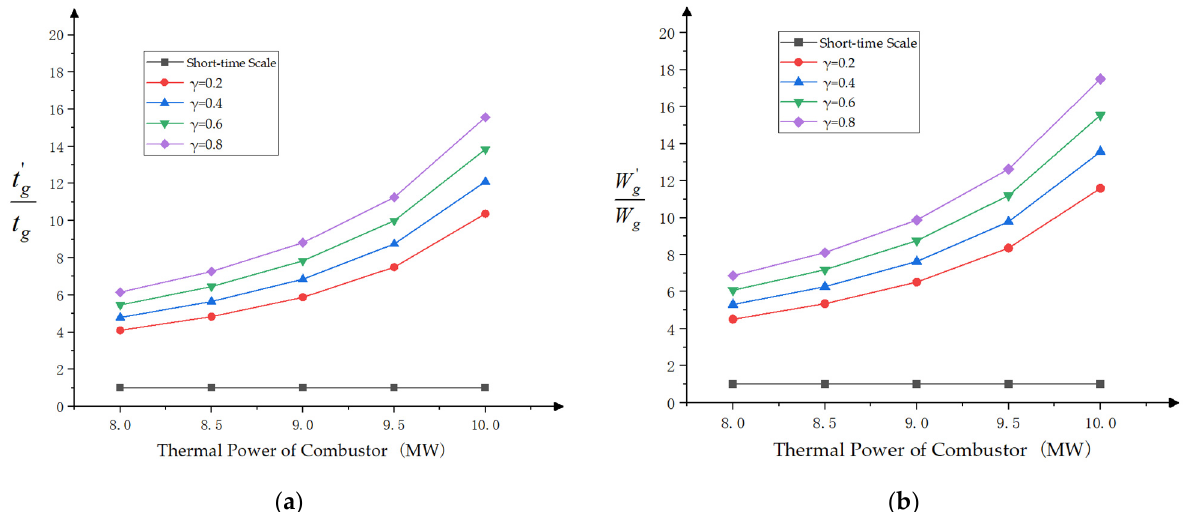
Figure 6. Relation diagram of different injection coefficients and burner thermal power with power-generation capacity and power-generation time: ( a ) power-generation time and ( b ) power-generation capacity.